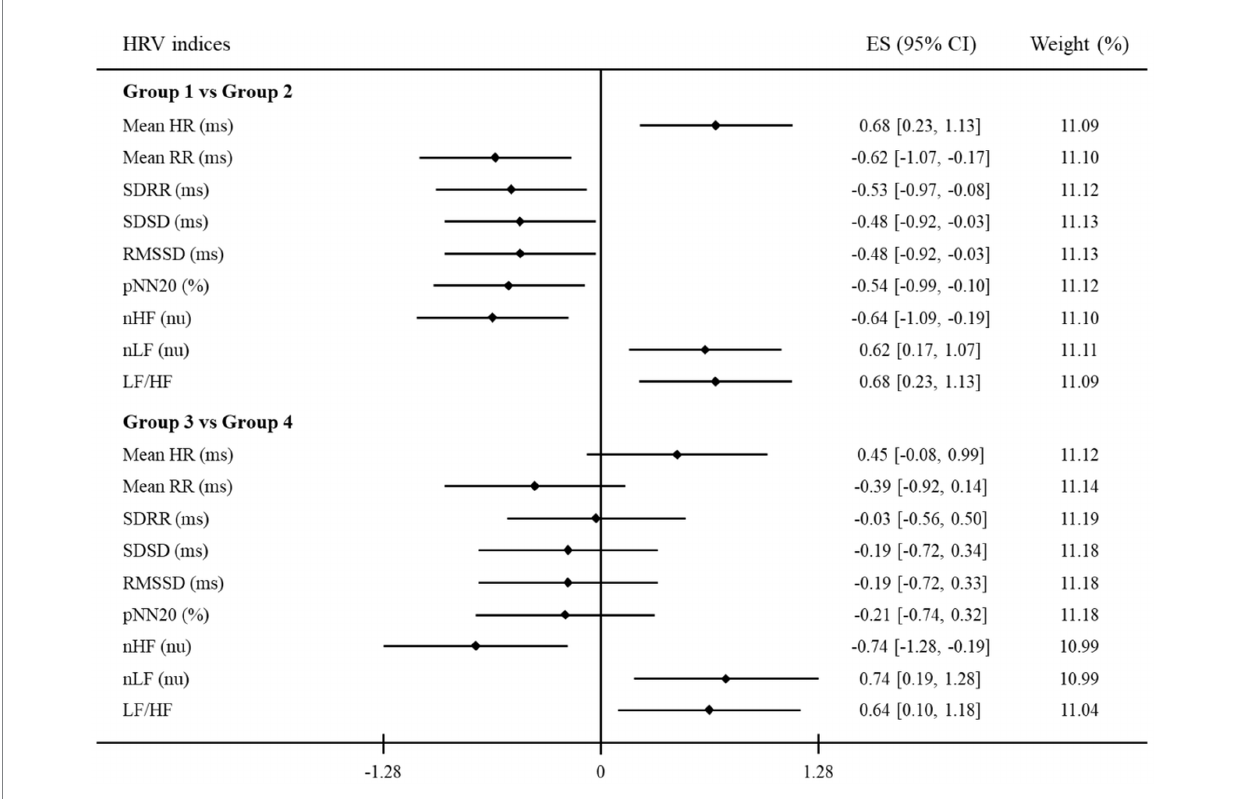
FIGURE 2 A forest plot showing the effect sizes (ES) and confidence intervals (CI) of HRV indices compared between groups. The vertical solid black line represents a mean difference of zero or no effect. Each black diamond shows the standardized mean difference. The upper and lower range of the line connected to the diamond shows the 95% CI for the ES. Group 1: clinician-rated and self-rated depression; Group 2: only self-rated depression; Group 3: clinician-rated and self-rated anxiety; Group 4: only self-rated anxiety. HRV, heart rate variability; Mean HR, mean heart rate; Mean RR, mean of all RR intervals; SDRR, standard deviation of all RR intervals; SDSD, standard deviation of differences between adjacent RR intervals; RMSSD, root mean square of successive RR interval differences; pNN20, percentage of differences between adjacent RR intervals >20 ms; nHF, normalized high- frequency power; nLF, normalized low-frequency power; LF/HF, low- to high-frequency